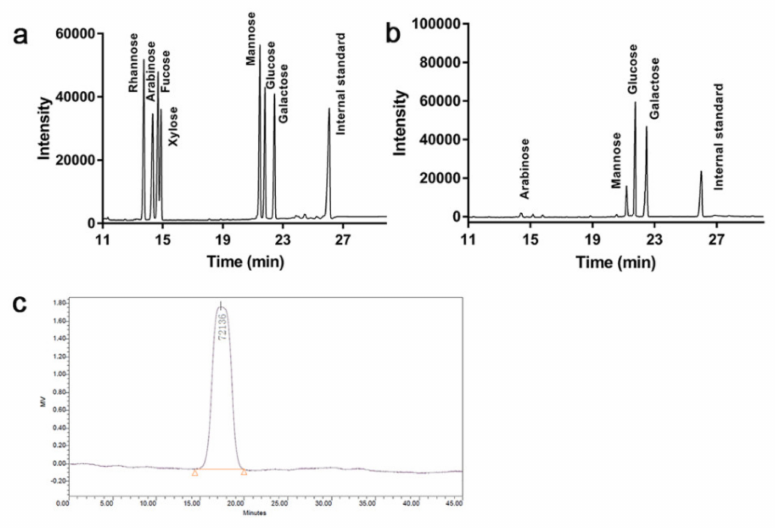
Figure 2. GC of standard monosaccharides ( a ) and Tmp ( b ); HPGPC of Tmp ( c